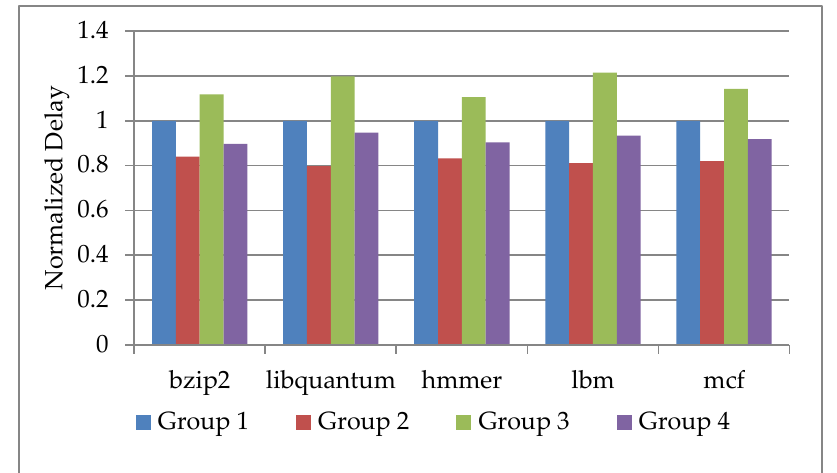
Figure 9. Comparison of System Delay normalized to Group 1.